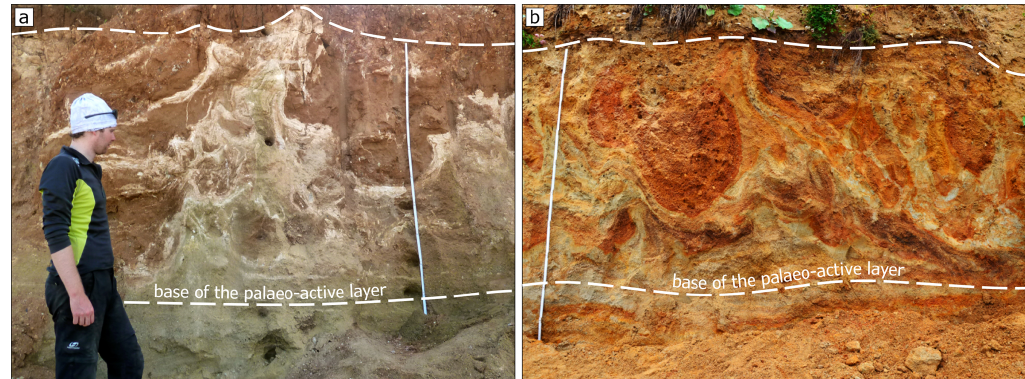
Figure 4. Cross sections through cryoturbation structures at the (a) Brno–ˇCernovice and (b) Nebanice sites, with the white dashed lines indicating their vertical extent and thereby the thickness of the palaeo-active layer. Note that the sections above the suggested base of the palaeo-active layer show distinct involution structures caused by freeze–thaw-induced processes, while those below have largely retained their primary structures with horizontal to sub-horizontal bedding